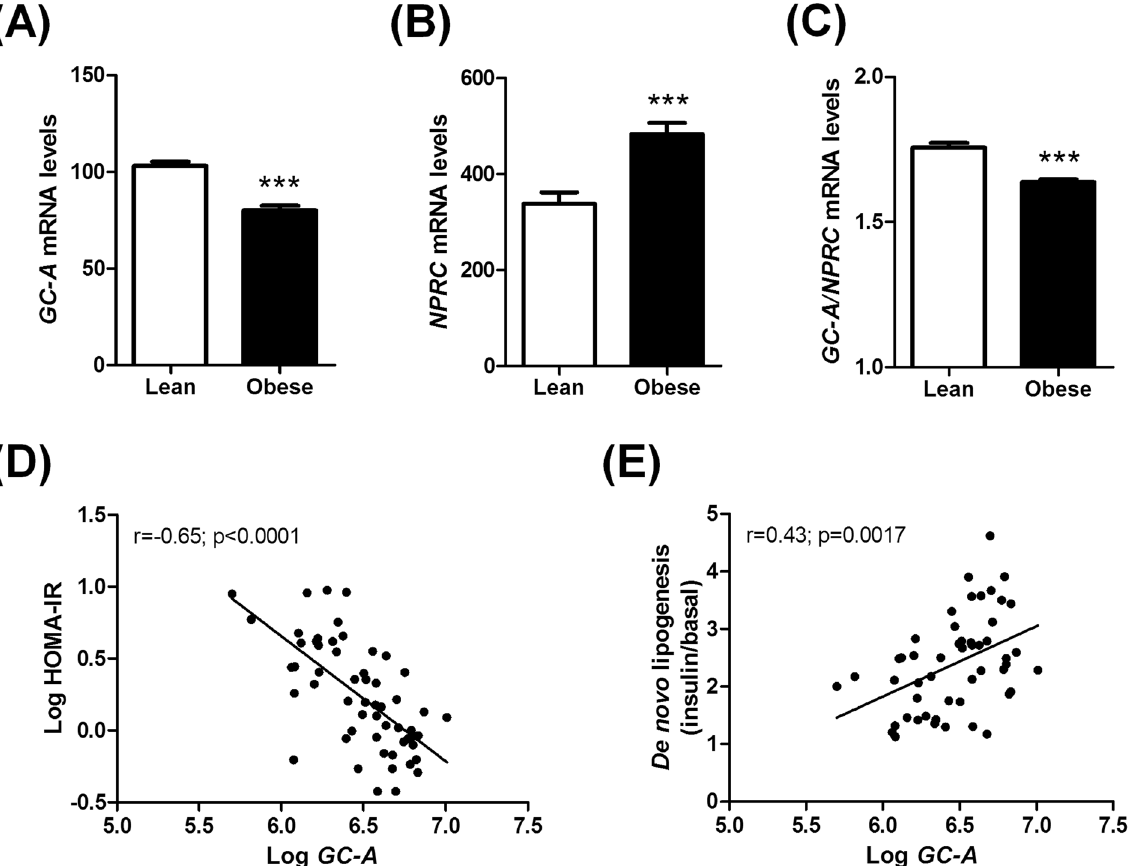
Figure 2. Human adipose tissue gene expression from microarrays of GC-A ( A ), NPRC ( B ), and the ratio of GC-A -to- NPRC ( C ) in lean versus obese individuals from cohort 2 (n = 56). Correlation between adipose GC-A expression and HOMA-IR ( D ) and de novo lipogenesis measured in isolated adipocytes ( E ). *** p < 0.0001 vs. lean.